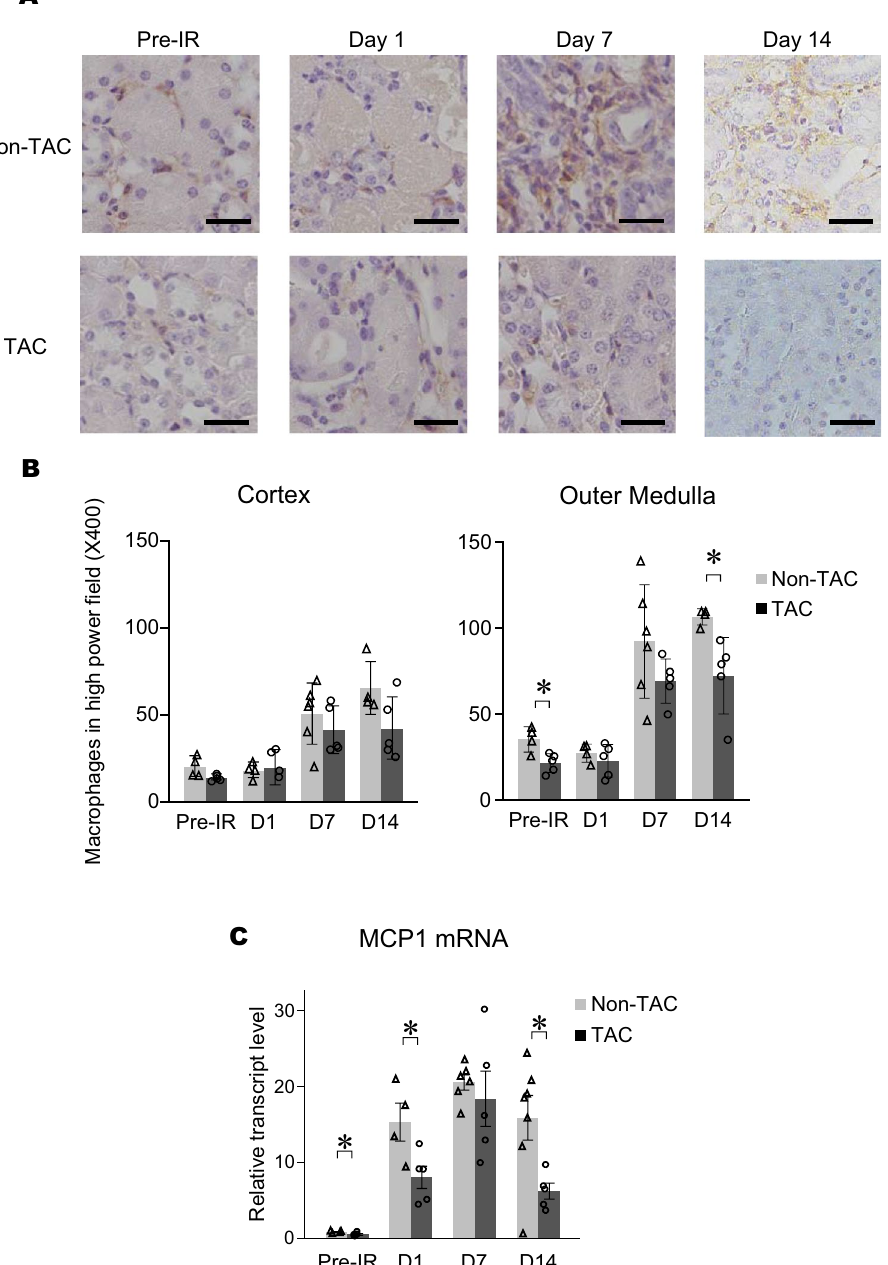
Figure 5. Macrophage infiltration and MCP1 mRNA expression after IR (Experiment 2). ( A ) Representative images of immunohistochemistry for F4/80 before, at 1, 7 and 14 days after IR (Bar = 25 μm). ( B ) Number of F4/80 positive cells in high power field (× 400) and ( C ) MCP1 mRNA expression (n = 4–5 per group). *p < 0.05. Gray bar and open triangle, non-TAC mice; black bar and open circle, TAC mice. All graphs were created using JMP 14.0 software (SAS Institute Inc., Cary,